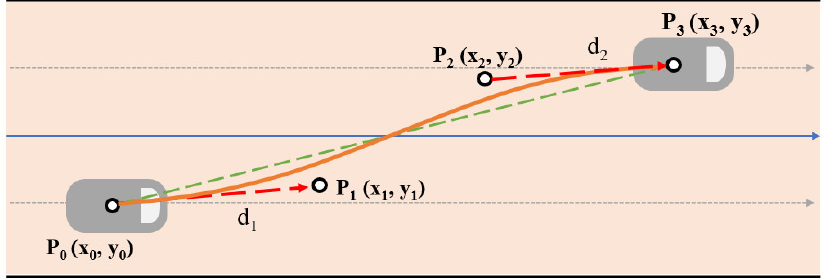
Figure 11. Third-order Bezier curve channel change model.